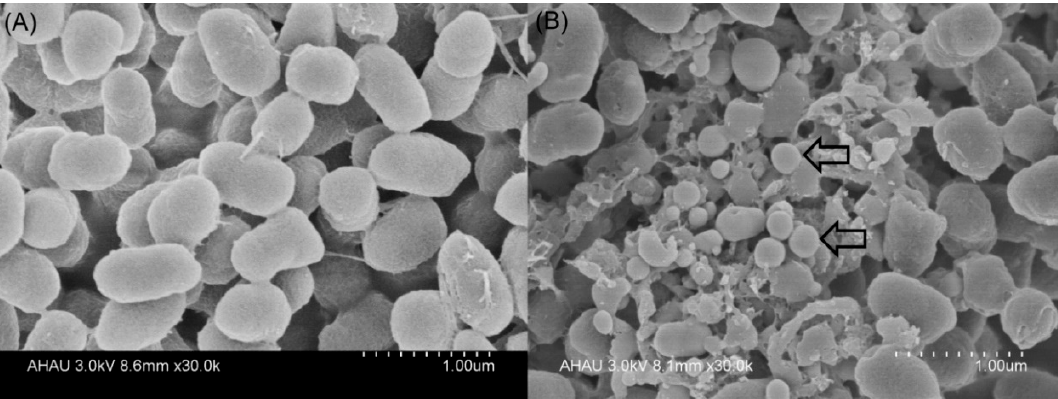
Figure 5. SEM micrographs of P. mirabilis YC801 grown without Na 2 SeO 3 ( A ) and with 5 mM Na 2 SeO 3 ( B ) after 36 h incubation. Electron-dense nanoparticles are located extracellularly as indicated by white arrows.